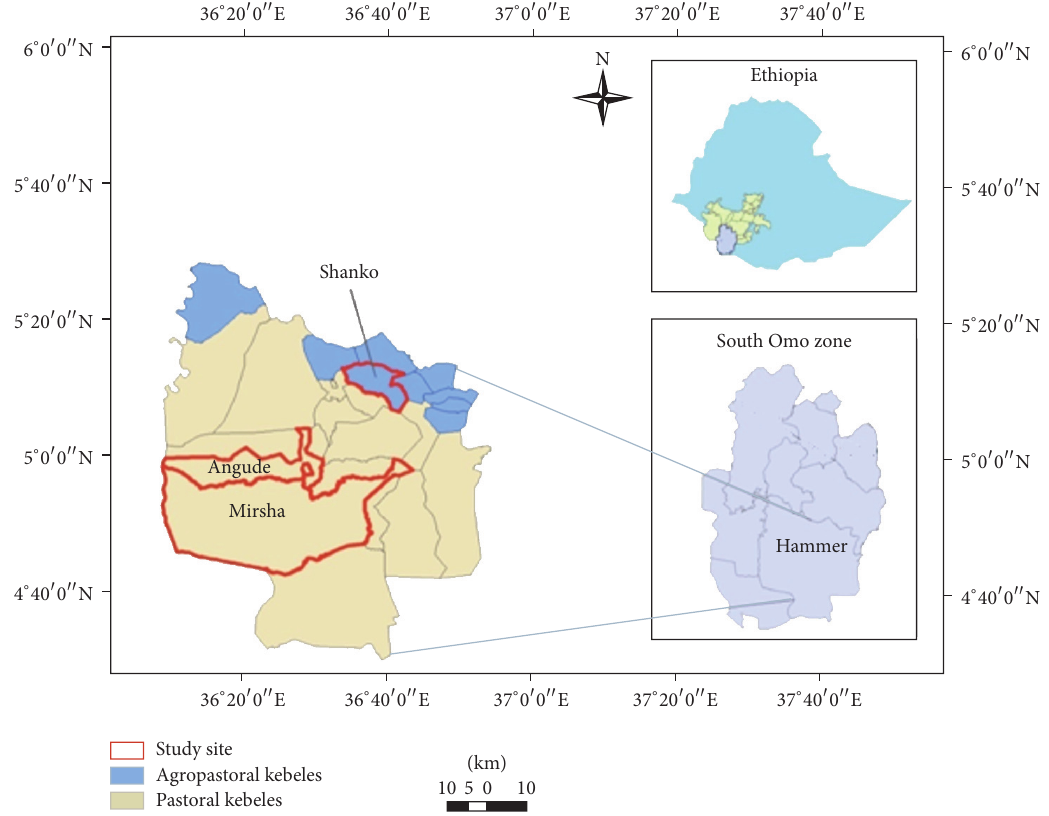
Figure 1: Location map of the study